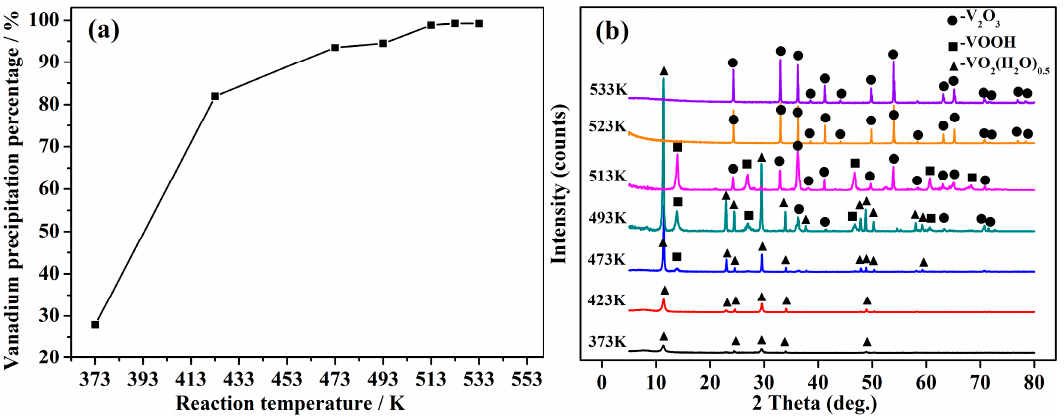
Figure 7. ( a ) Effect of reaction temperature on the vanadium precipitation percentage; ( b ) XRD patterns of the precipitates obtained at different reaction temperature.